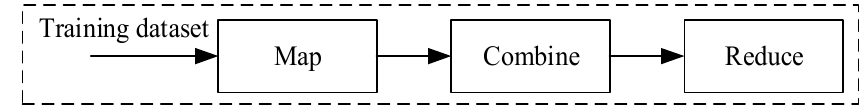
Figure 9. The process of training back propagation ( BP) neural network model.